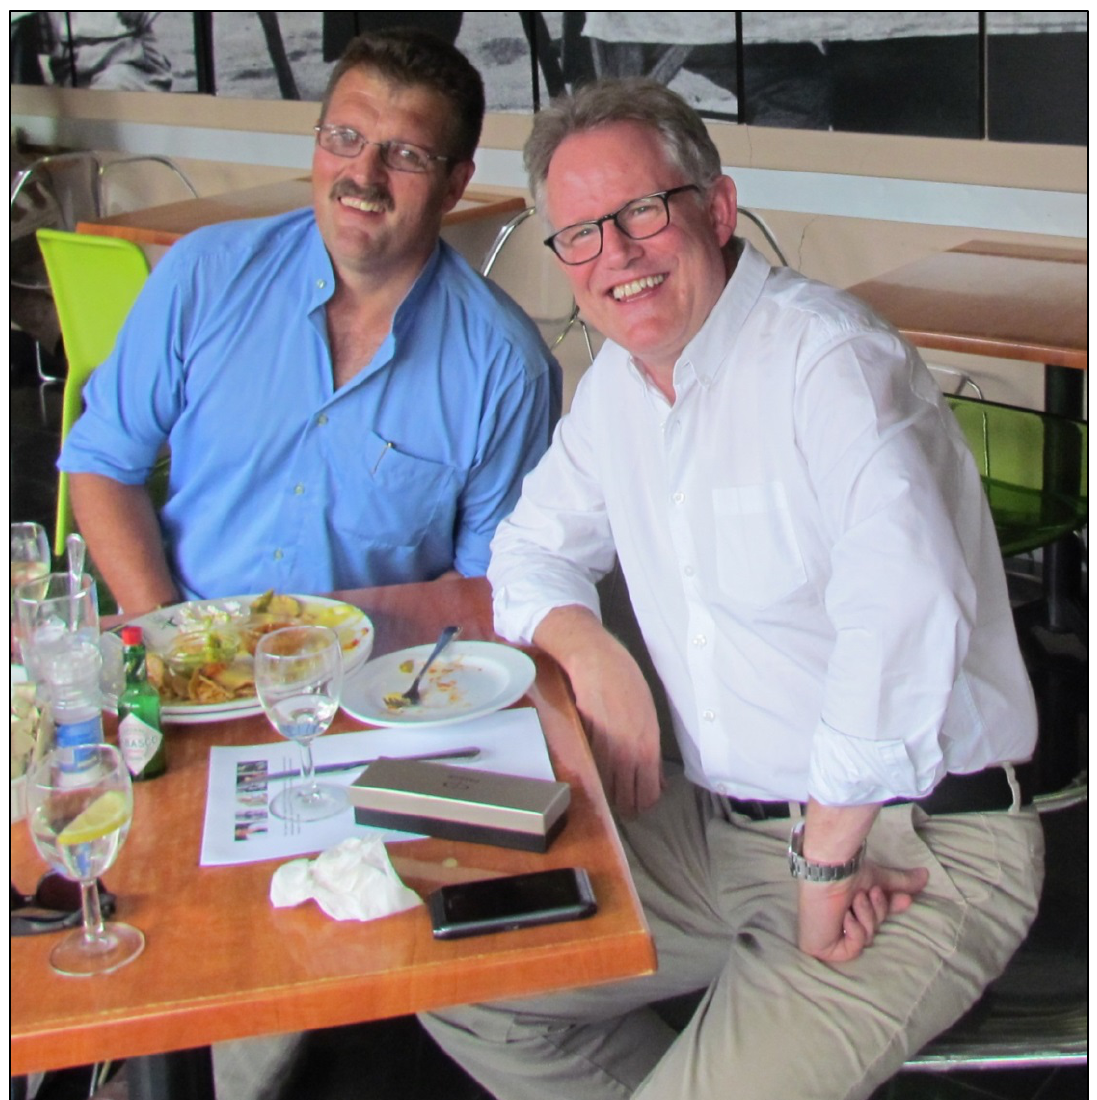
Figuur 2: ŉ Waarderende onderhoud is op 25 Januarie 2013 met Coenie de Villiers